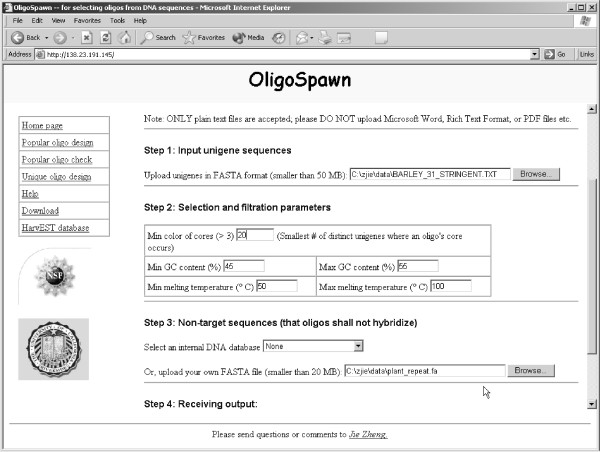
Screenshot of the web interface of OLIGOSPAWN for the popular oligo design.